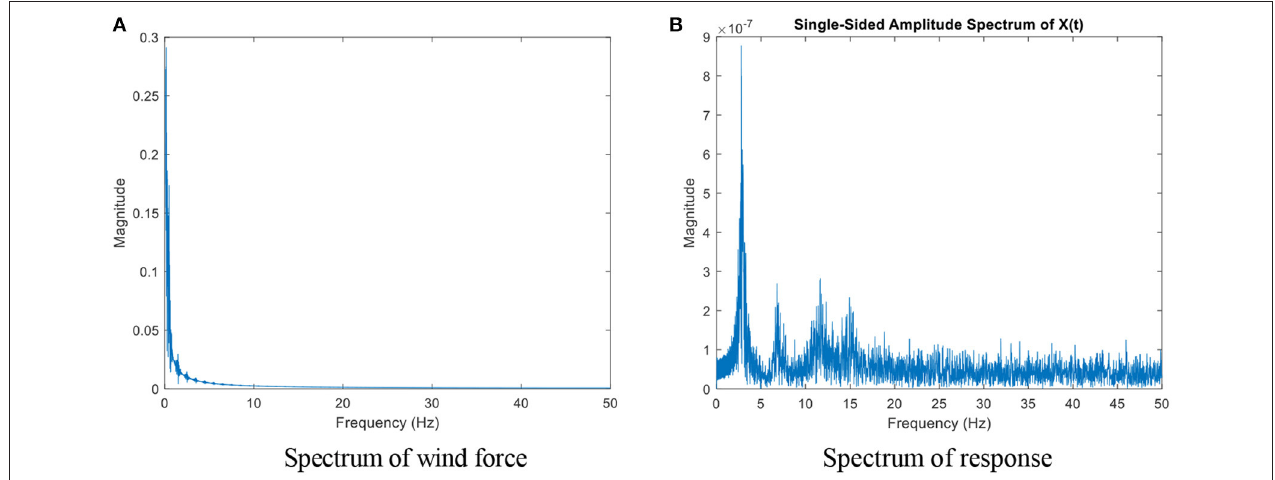
FIGURE 3 | Spectra of wind force and response of a 4 Story Building. (A) Spectrum of wind force. (B) Spectrum of response.